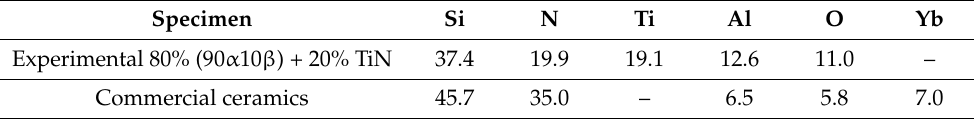
Table 5. Results of elemental quantitative EDX analysis of sintered ceramics based on SiAlON.